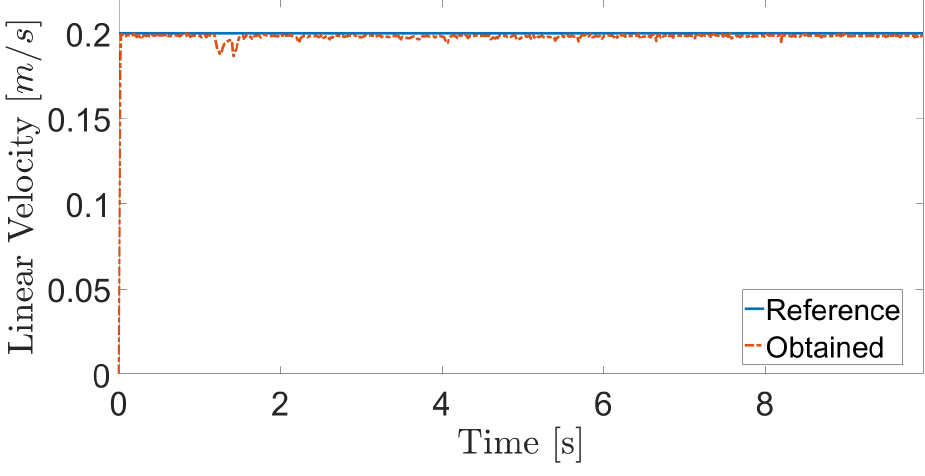
Figure 17. Linear velocity in the adhesion loss